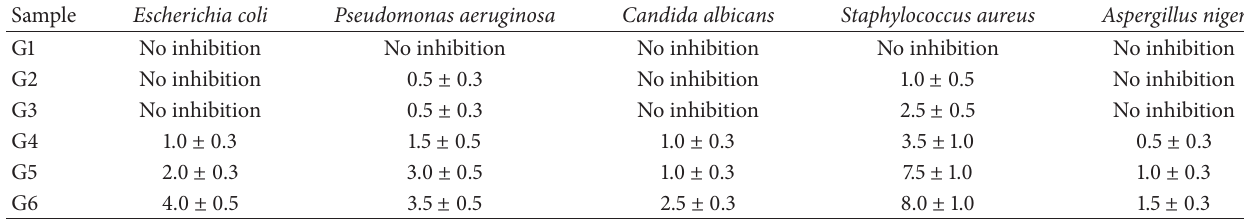
Table 5: Changes of pH, viscosity, and NaSal concentration of the hydrogels after 1 year of storage at 8 and 25 ∘ C.